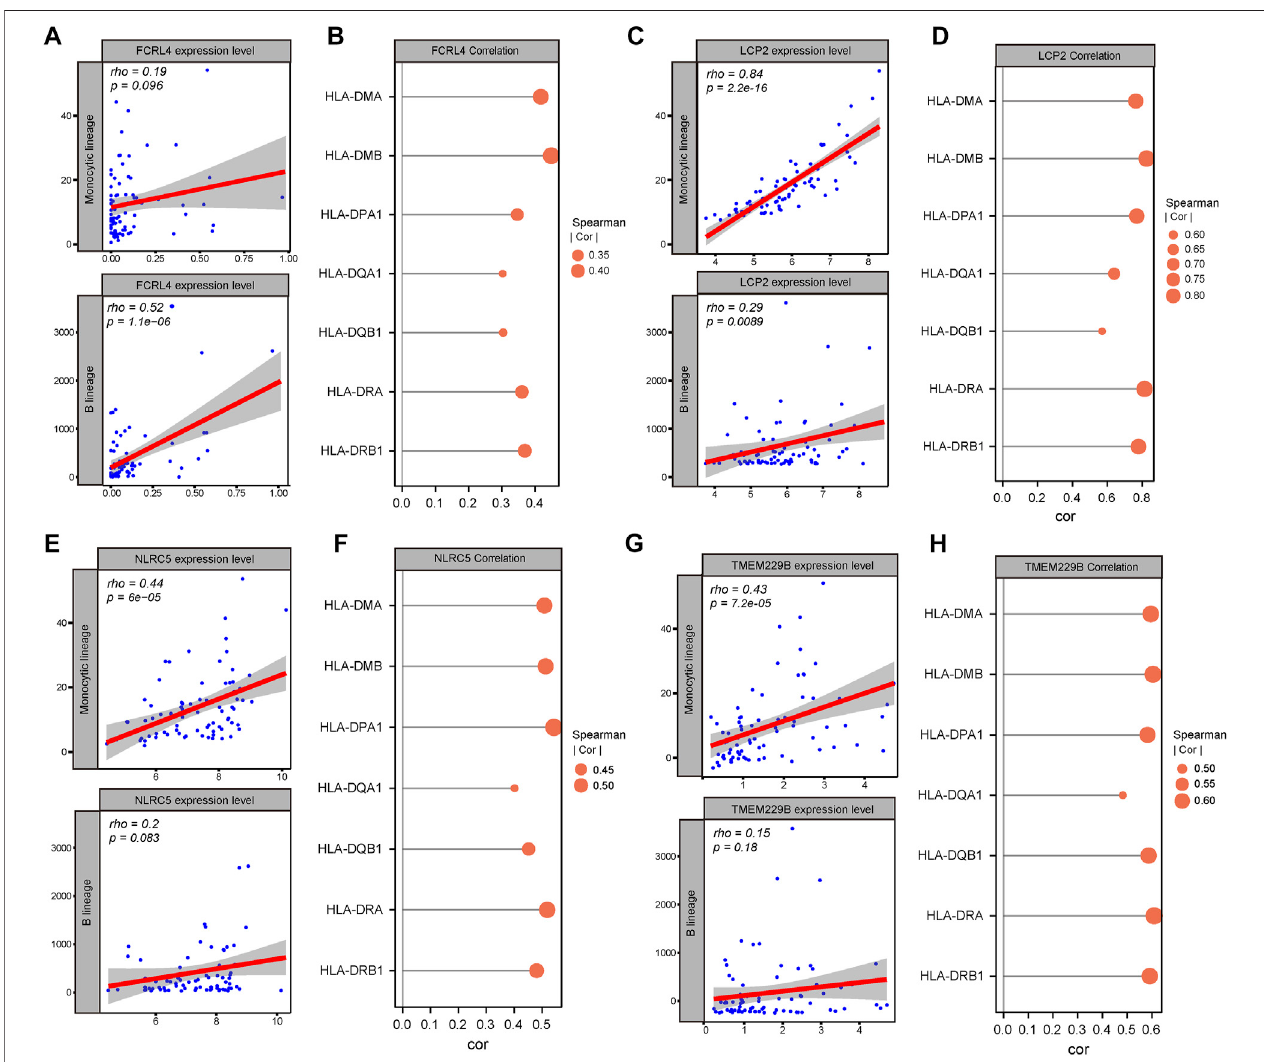
FIGURE 4 | Identi fi cation of candidate tumor antigens associated with APCs and MHC class II. (A) Correlation between FCRL4 expression and estimated macrophage and B cell scores. (B) Correlation between FCRL4 expression and MHC II expression. (C) Correlation between LCP2 expression and estimated macrophages and B cells scores. (D) Correlation between LCP2 expression and MHC II expression. (E) Correlation between NLRC5 expression and estimated macrophages and B cells scores. (F) Correlation between NLRC5 expression and MHC II expression. (G) Correlation between TMEM229B expression and estimated macrophage and B cell scores. (H) Correlation between TMEM229B expression and MHC II expression.